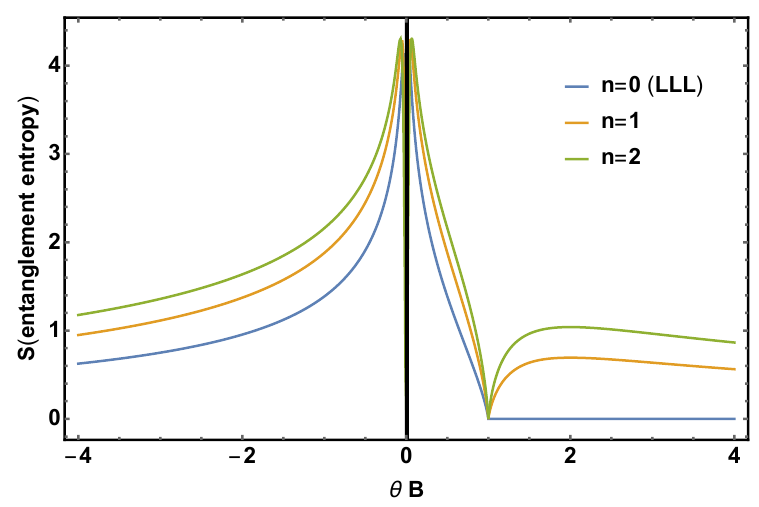
Figure 1: Entanglement entropy for the minimum angular momentum states corre- sponding to lowest, first and second Landau